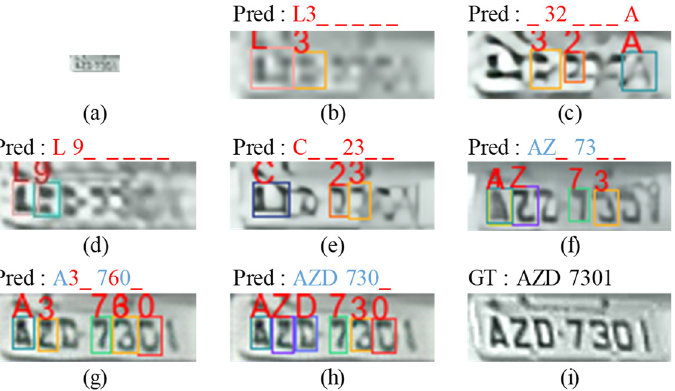
Figure 9. LP recognition results on ( a ) input low-quality legacy image (24 × 8), ( b ) bicubic image (96 × 32), ( c ) MZSR result, ( d ) DRN result, ( e ) SwinIR result, ( f ) HIFA-LPR (Step 1) result, ( g ) HIFA-LPR (Step 2) result, ( h ) HIFA-LPR (Step 3) result, ( i ) HR image. “_” denotes a missing character. Red character denotes an incorrect prediction. Blue character denotes a correct prediction. “GT” denotes ground truth. “Pred” denotes the prediction result.